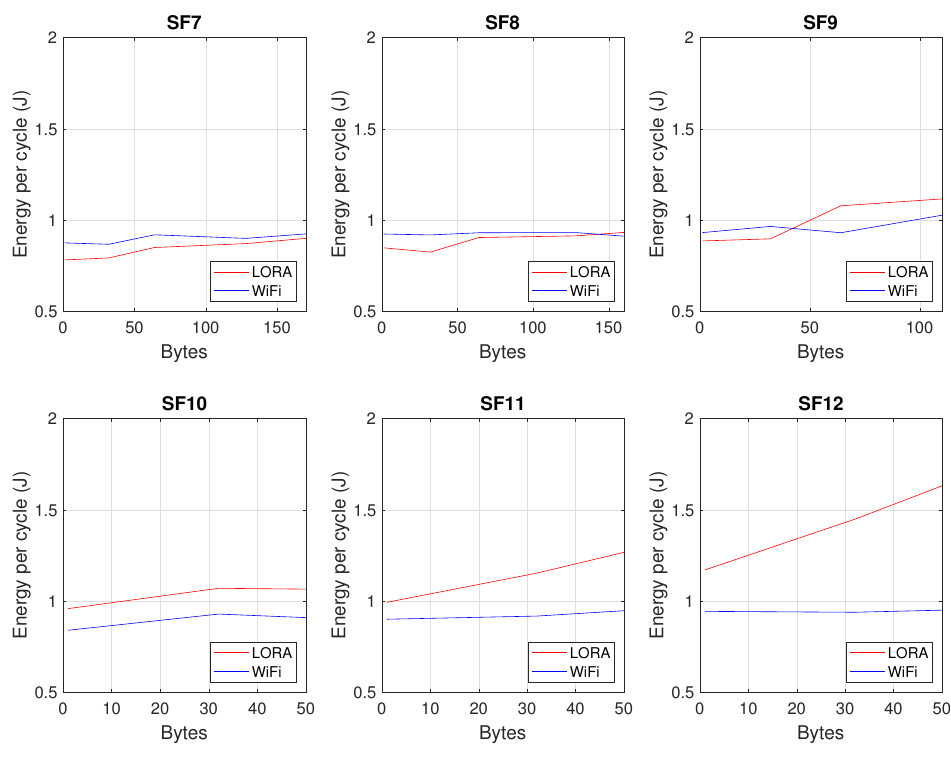
Figure 12. Energy consumption by the sensor node for different Spreading Factors (SFs).